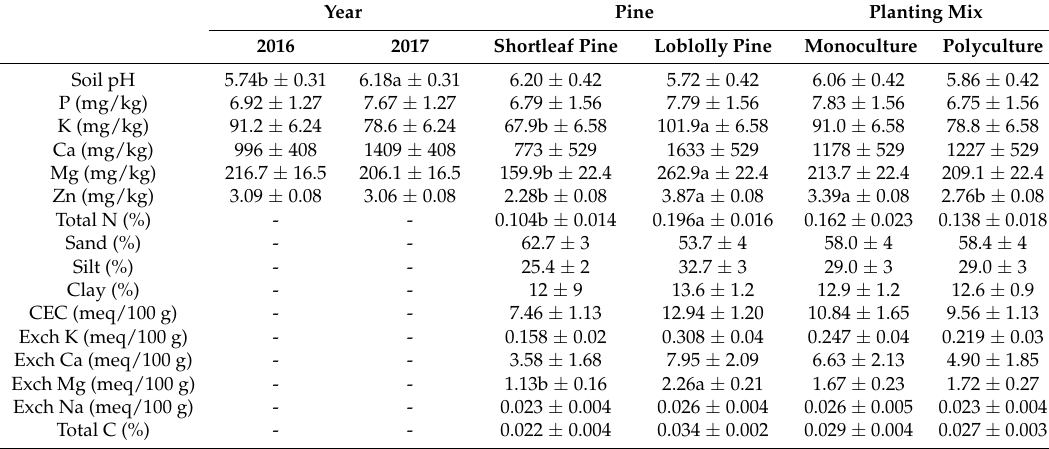
Table 1. Soil data (means ± SE) for soil samples collected from reforestation plots (three plots planted in loblolly pine and three plots planted in shortleaf pine) in Eastern Kentucky. Each plot was subdivided into pine-hardwood polyculture and pine-only monoculture subplots. Means with differing letters are significantly different, as detected by ANOVA and followed up by a student’s t -test, at p < 0.05. “Exch” =